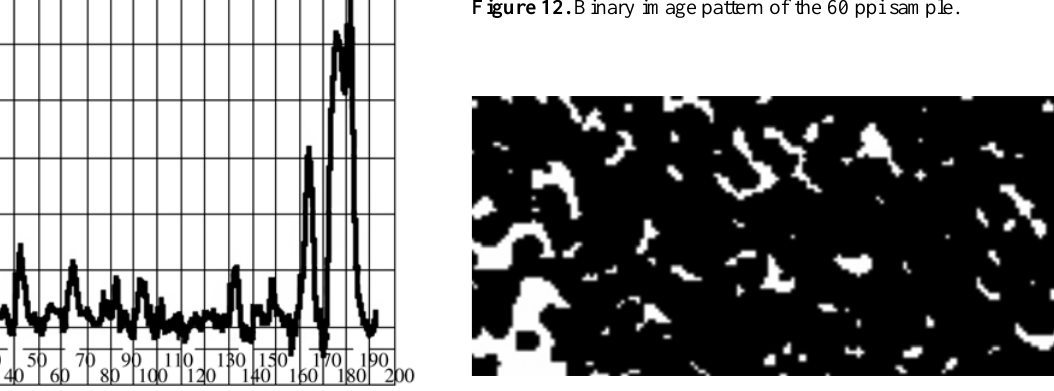
Figure 13. Binary image pattern of the 75 ppi sample.